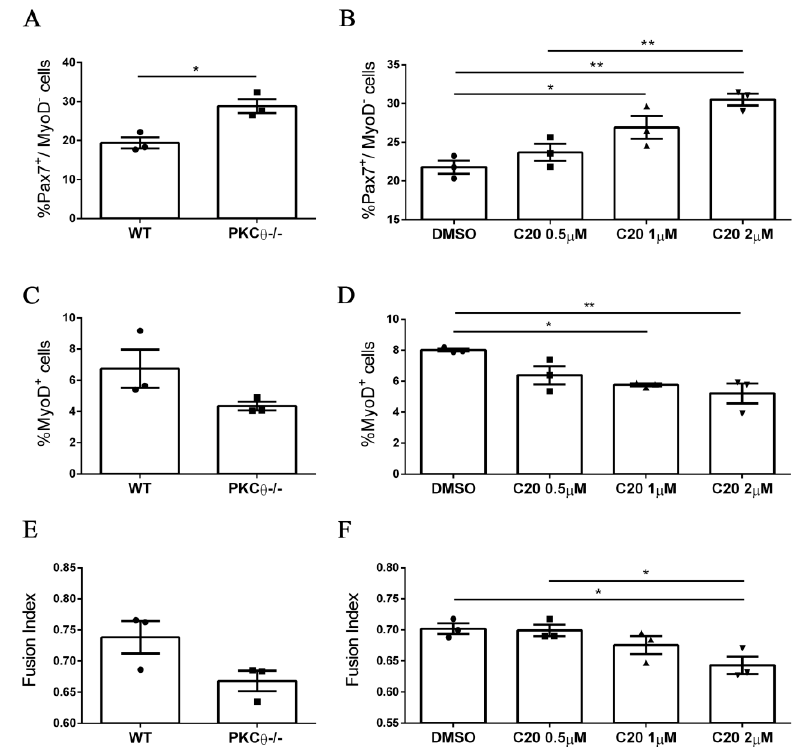
Figure 4. Pharmacological inhibition of PKC θ increases the fraction of reserve cell population in cultured primary myoblasts. ( A ): Percentage of Pax7 + / MyoD − SCs in WT and PKC θ - / - cultures, or in WT cultures treated with increasing concentration of C20 ( B ); cells were cultured for 4 days in GM followed by2 days in DM. ( C ): Percentage of total MyoD + SCs in WT and PKC θ - / - cultures, or in WT cultures treated with C20, as in B ( D ). ( E ): Fusion index of WT and PKC θ - / - myotubes, or WT myotubes treated with C20 ( F ) as in A ( n = 3 replicate dishes per group). Error bars represent mean ± sem, * p < 0.05, ** p < 0.01 calculated by one-way ANOVAwith adjustment for multiple comparison test. 2.5. PKC θ Absence/Inhibition Increases the Quiescent Satellite Cell Pool after Induction of Acute injury